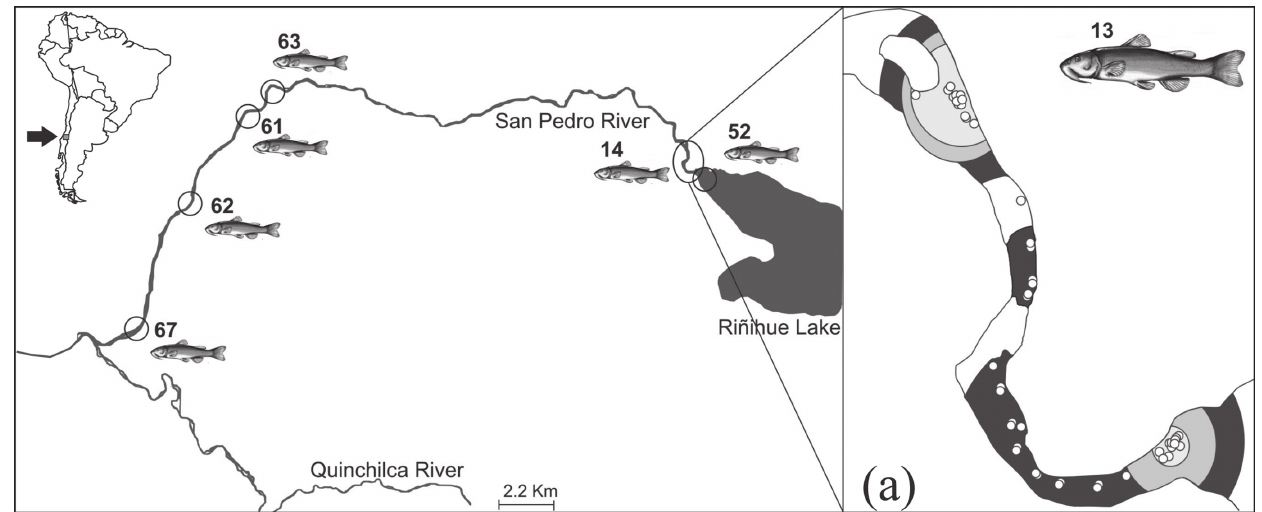
Fig. 1. Study area showing the main course of the San Pedro River, which has its origin in the Riñihue Lake outlet. The confluence with the Quinchilca River is located 40 kilometres downstream, forming the Calle-Calle River. Zoomed area represents kernel home range for individual RT 13. Areas in dark grey, light grey, and white correspond to estimation using 95%, 70% and 50% density,